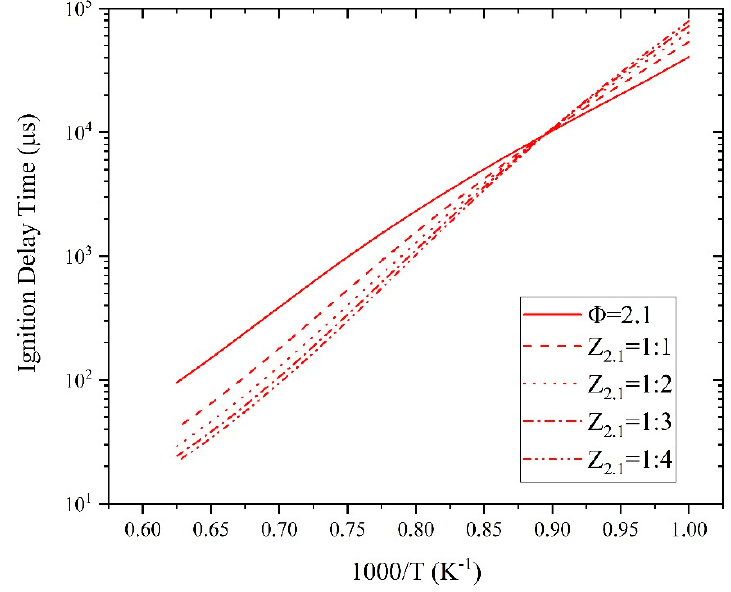
Figure 5. Comparison of the ignition delay times of n -pentane at an equivalence ratio of 2.1 and air– light hydrocarbon mixing gas at mixing degree of 1, 1/2, 1/3, and 1/4, respectively.